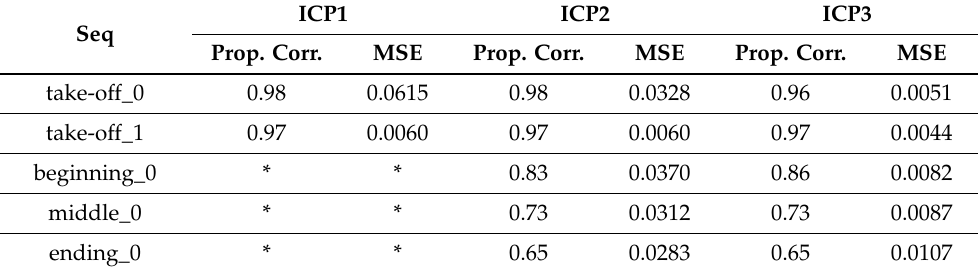
Table 2. Álora global localization